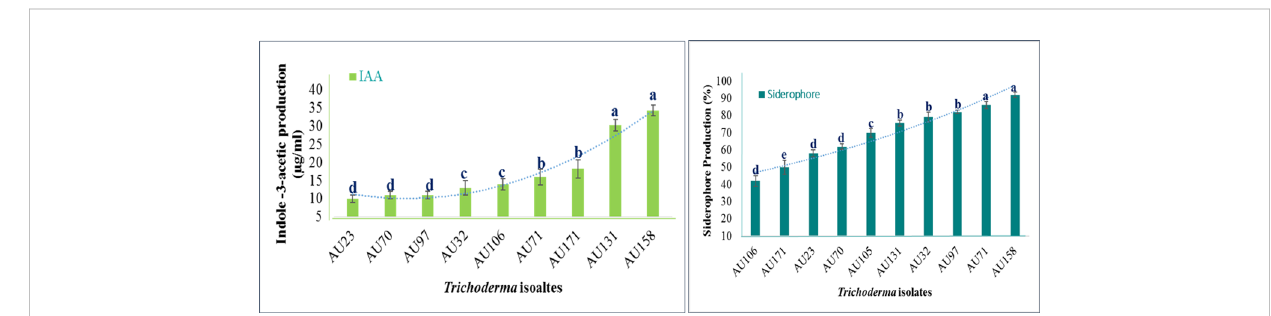
FIGURE 5 Quantitative estimates of the plant growth-promoting attributes of Trichoderma isolates Trichoderma isolates: T. viride AU23, T. longibrachiatum AU32, T. koningiopsis AU70, T. asperelloides AU71, T. asperellum AU97, T. aethiopicum AU106, T. asperellum AU131, T. longibrachiatum AU158 and T. asperellum AU171. Each value is the average of three duplicate samples with standard error, and various alphabets shown indicated mean treatments that are substantially different according to Tukey ’ s HSD posthoc test at p ≤ 0.05.